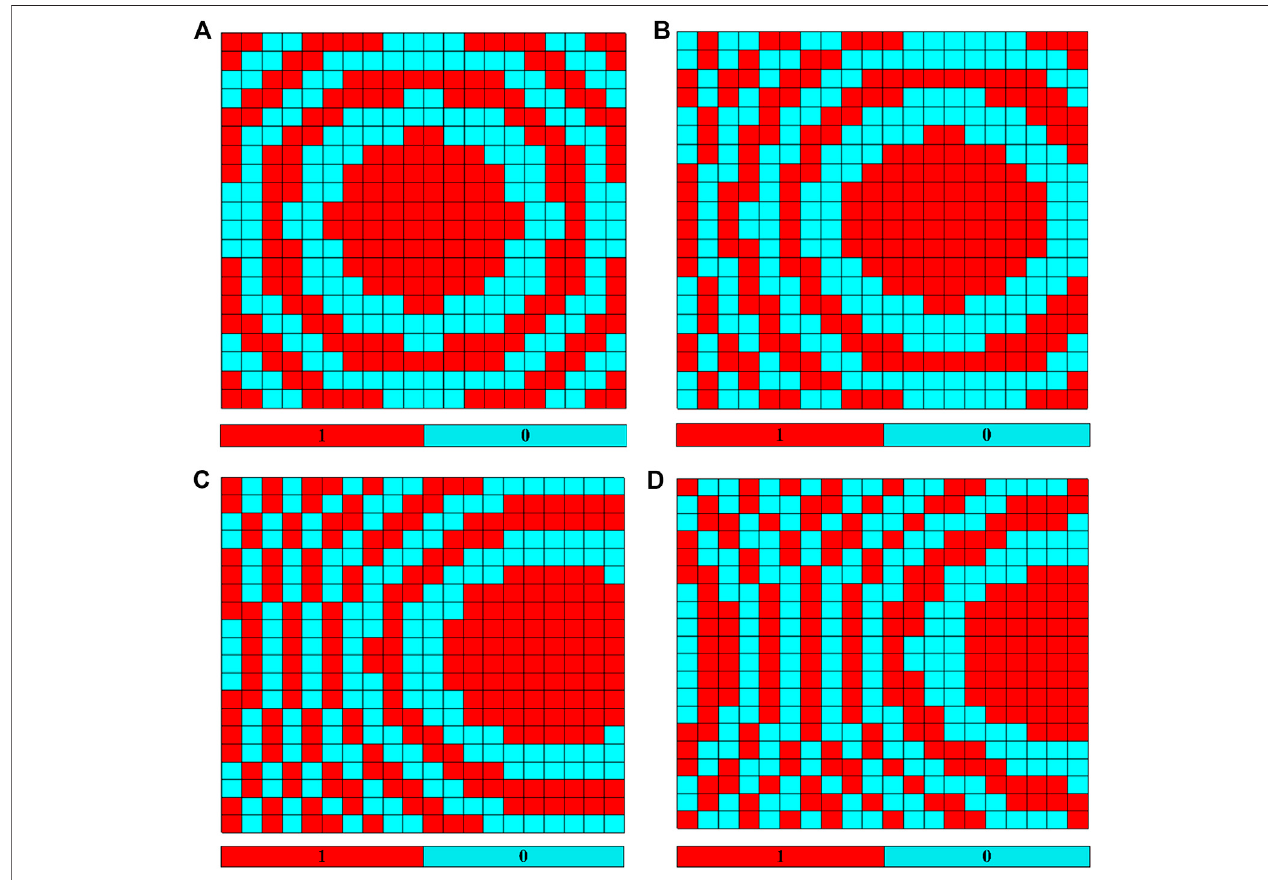
FIGURE 4 | Optimal quantized phase code distributions for four beam directions (A) θ (cid:1) 0 ° (B) θ (cid:1) 15 ° (C) θ (cid:1) 30 ° (D) θ (cid:1) 45 ° .